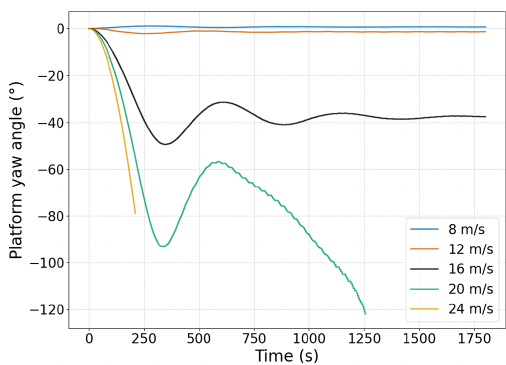
Figure 7. Platform yaw drift for 8 (blue), 12 (orange), 16 (black), 20 (green) and 24ms − 1 (yellow)